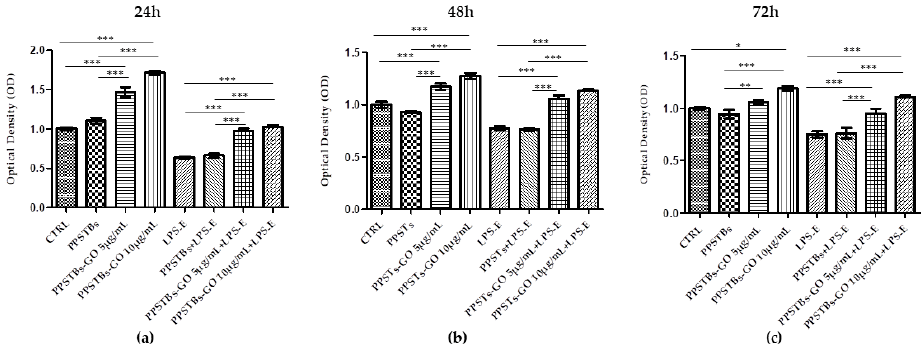
Figure 2. The cell metabolic activity of hGFs with PPSTBs enriched with GO 5 μ g/mL and GO 10 μ g/mL at ( a ) 24 h, ( b ) 48 h, and ( c ) 72 h. * p < 0.05; ** p < 0.01; *** p < 0.001.